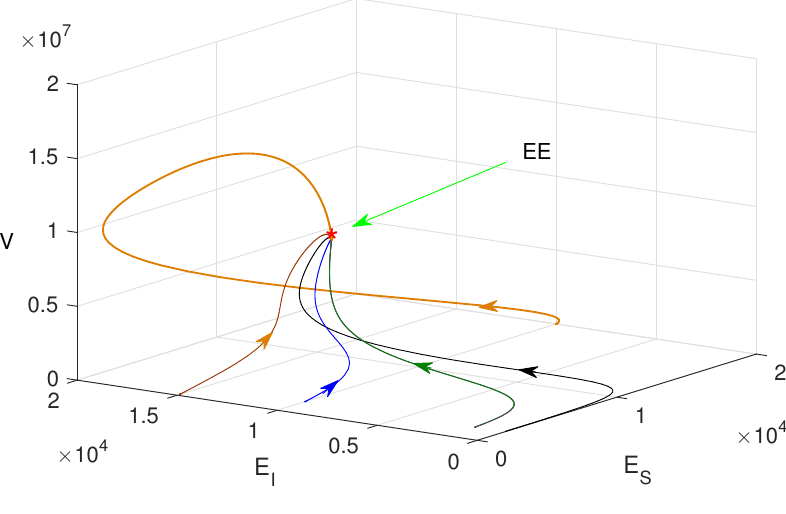
Figure 6. Phase portraits plotted in E S − E I − V phase-space with different initial conditions and R 0 >